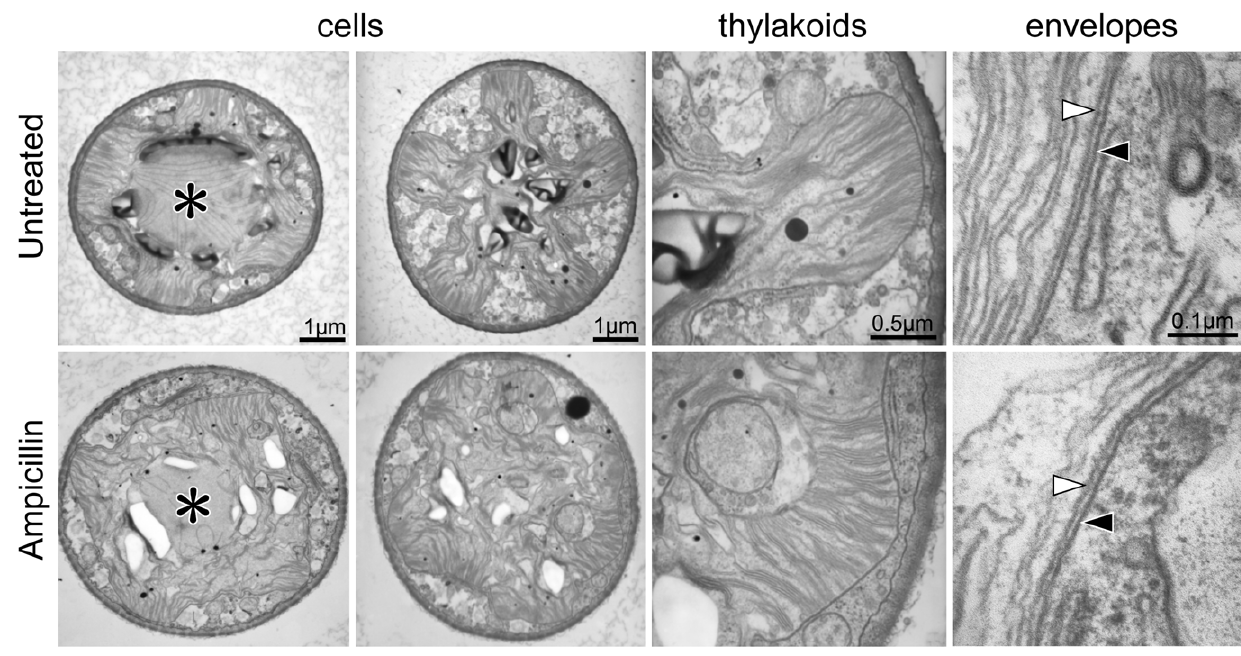
Figure 3. Electron micrographs of ampicillin-treated Closterium cells and of untreated controls. The magnification in the lower photos is the same as that in the upper photos. Pyrenoids surrounded by starch are indicated by asterisks. Black and white triangles indicate the outer and inner envelopes of chloroplasts, respectively.